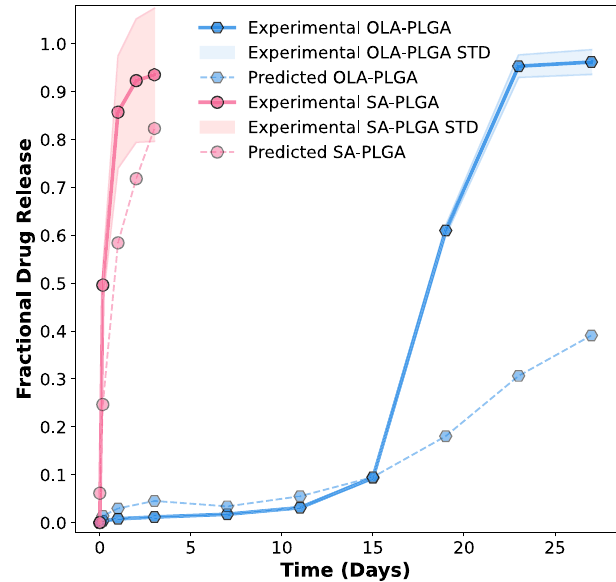
Fig. 7 | Comparison of the experimental and predicted fractional drug release pro fi les for thesalicylicacid-PLGA MP(SA-PLGA) and olaparib-PLGA MP(OLA- PLGA)formulations. ThedesignofboththeSA-PLGAandOLA-PLGAwasbasedon SHAP analysis of the trained LGBM model. Three independent batches of both formulationswereprepared,andtheirexperimentaldrugreleasewascharacterized in 0.5wt% sodium dodecyl sulfate (SDS) to ensure sink conditions throughout the experiments. The fractional experimental drug release pro fi les for SA-PLGA and OLA-PLGA are plotted together as pink circles with a solid line (SA-PLGA) and blue hexagons with a solid line (OLA-PLGA), respectively. In both cases, the standard deviation (STD) observed for these experimental drug release measurements is displayedasacoloredhalo( n =3).Thefractionaldrugreleasepro fi lespredictedby the LGBM model are also shown as pale pink circles with a broken line (SA-PLGA) and pale blue hexagons with a broken line (OLA-PLGA), respectively. Source data are provided as a Source Data fi